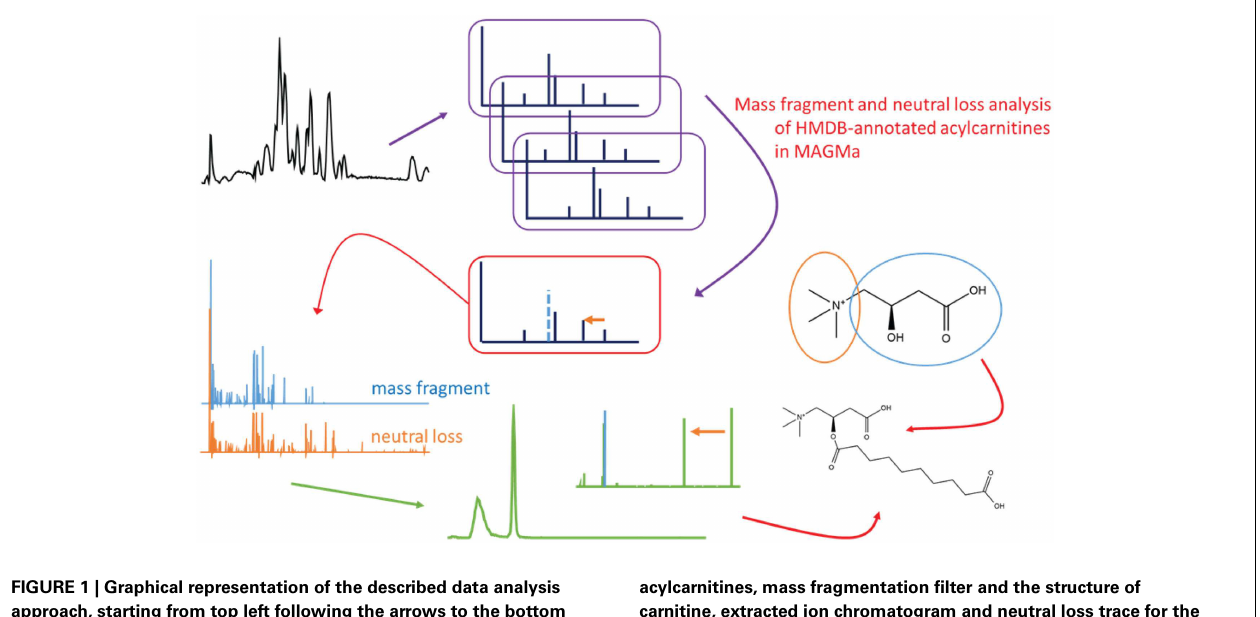
FIGURE 1 | Graphical representation of the described data analysis approach, starting from top left following the arrows to the bottom right: untargeted mass chromatogram, fragmentation data acquisition, HMDB annotation and fragment annotation in MAGMa to find specific mass fragments and neutral losses for